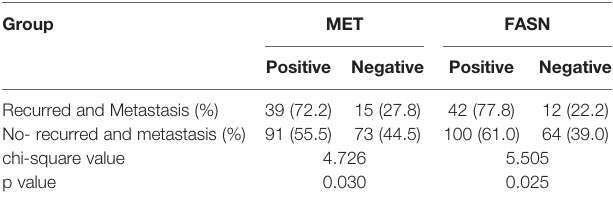
TABLE 4 | Correlation analysis of MET and FASN with the recurrence and metastasis. Group MET FASN